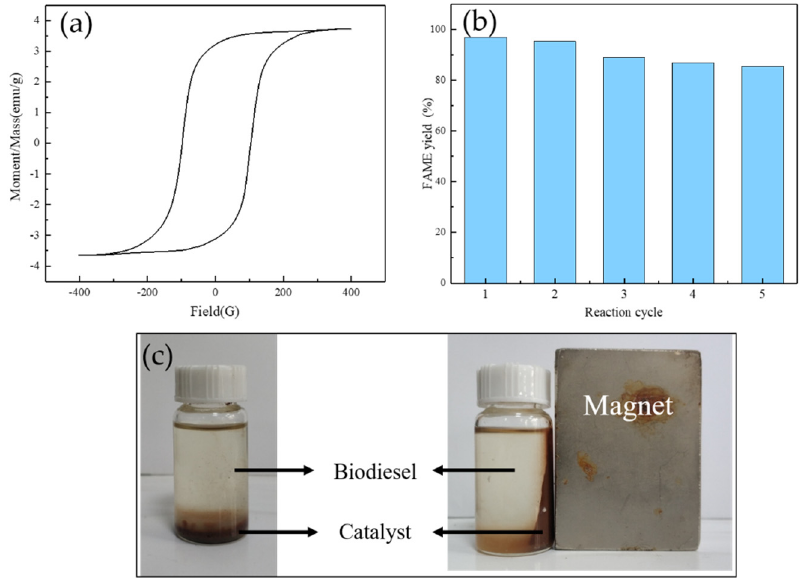
Figure 9. ( a ) VSM analysis of Ca80Fe20; ( b ) Reusability analysis of Ca80Fe20; ( c ) Photograph of Ca80Fe20 attracted by magnet in biodiesel.